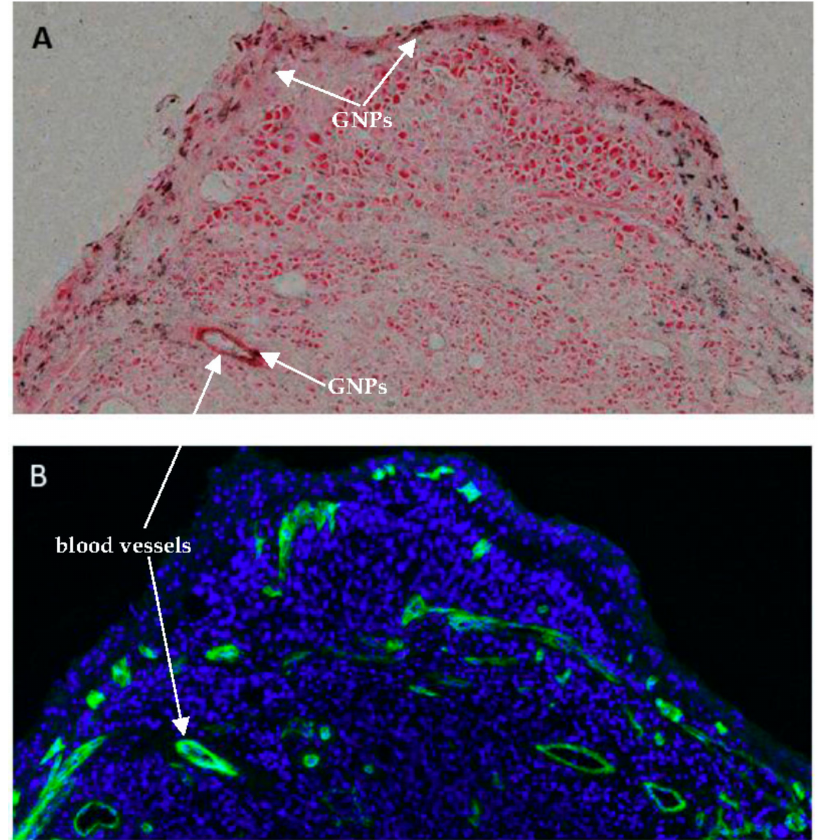
Figure 7. GNP accumulation in tumor ( A ) silver stained GNPs (shown in black) accumulated in eosin stained section of tumor; ( B ) section of tumor with cell nucleus stained with DAPI (4 (cid:48) ,6-Diamidino-2-phenylindole dihydrochloride; shown in blue) and blood vessels marked with CD31 (shown in